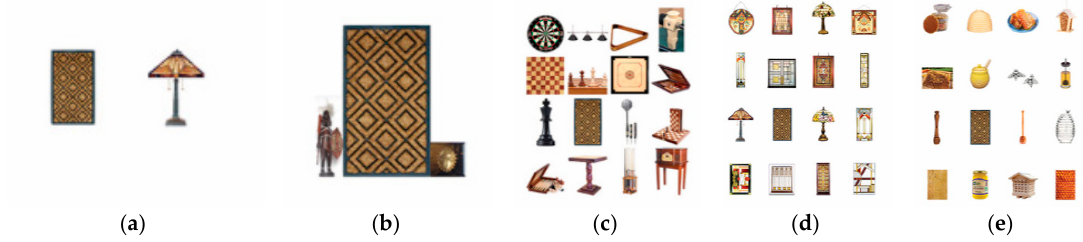
Figure 1. ( a – e ) Arrangements and their meaning, A Matter of Arrangements, Pauline Guex, MA Thesis, 2013. Archive Visual Communication Institute, the Basel School of Design HGK